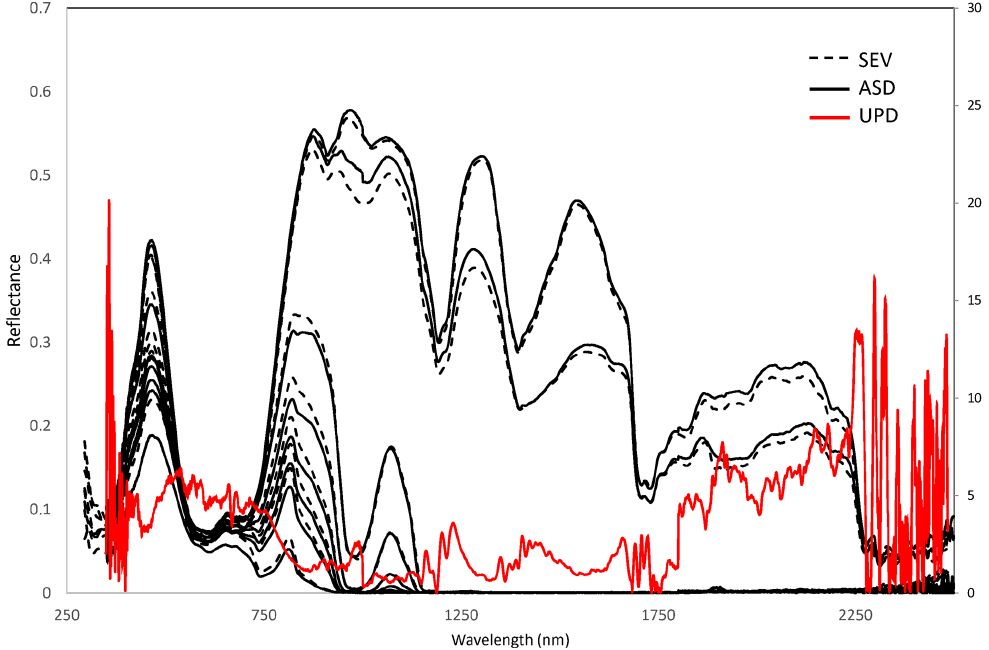
Figure 12. Comparison of ASD and SEV with unbiased percentage difference (UPD) for the blue rope.